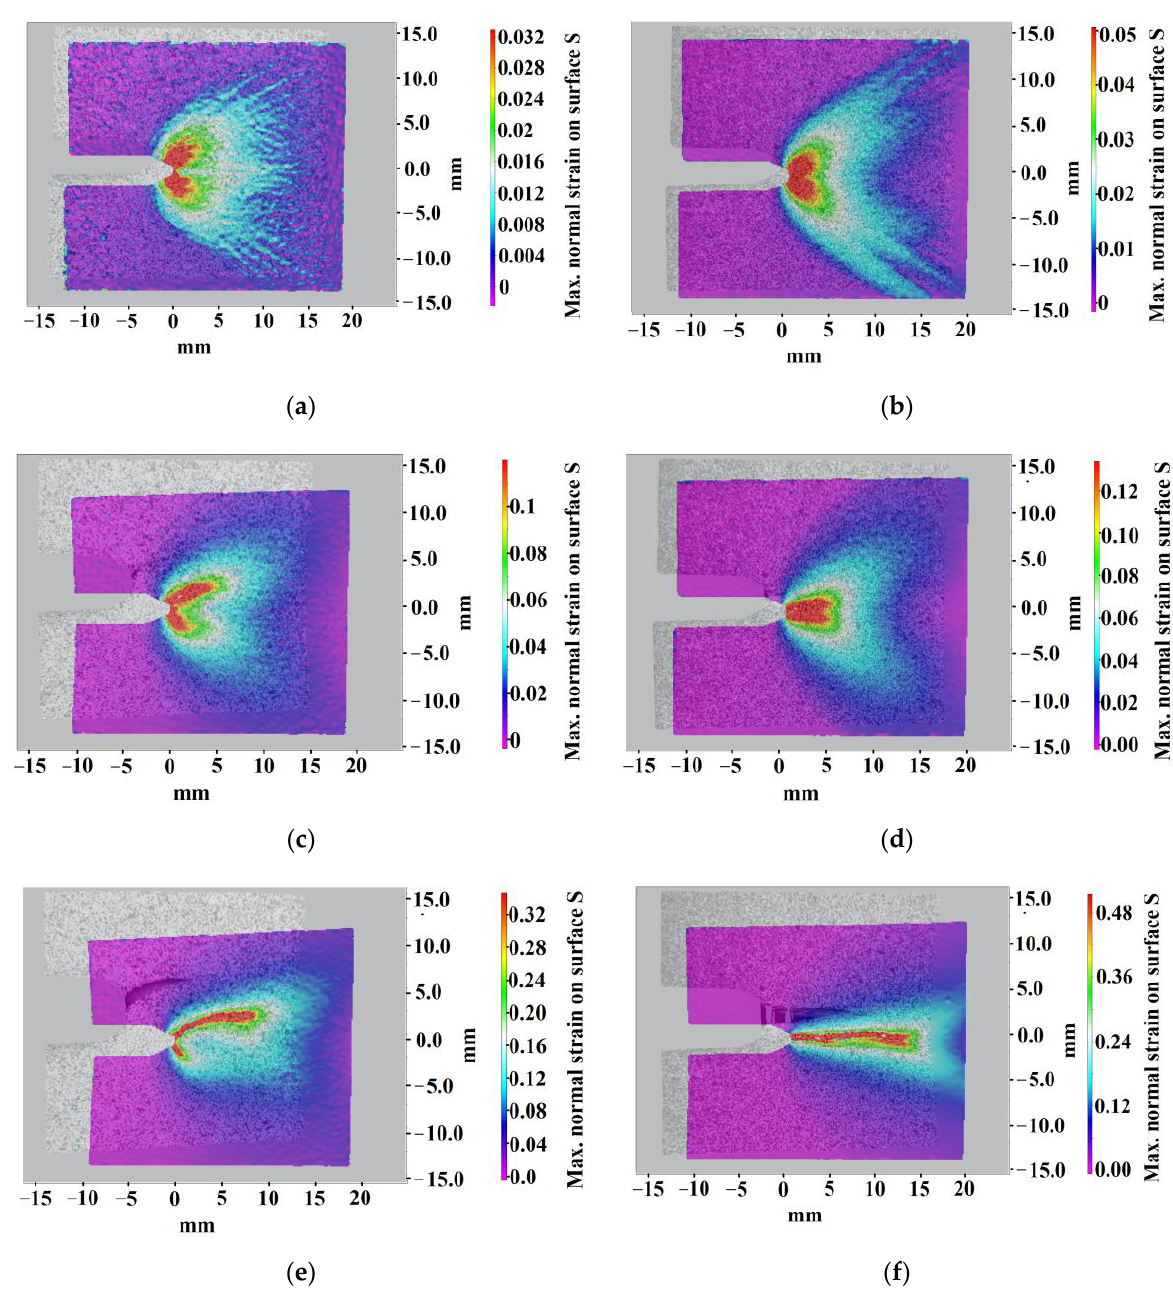
Figure 11. Photos of strain fields for a specimens of 1 mm thick (left) and 6 mm thick (right) at different stages of crack development: crack initiation ( a , b ); crack propagation ( c , d ); before failure ( e , f ).